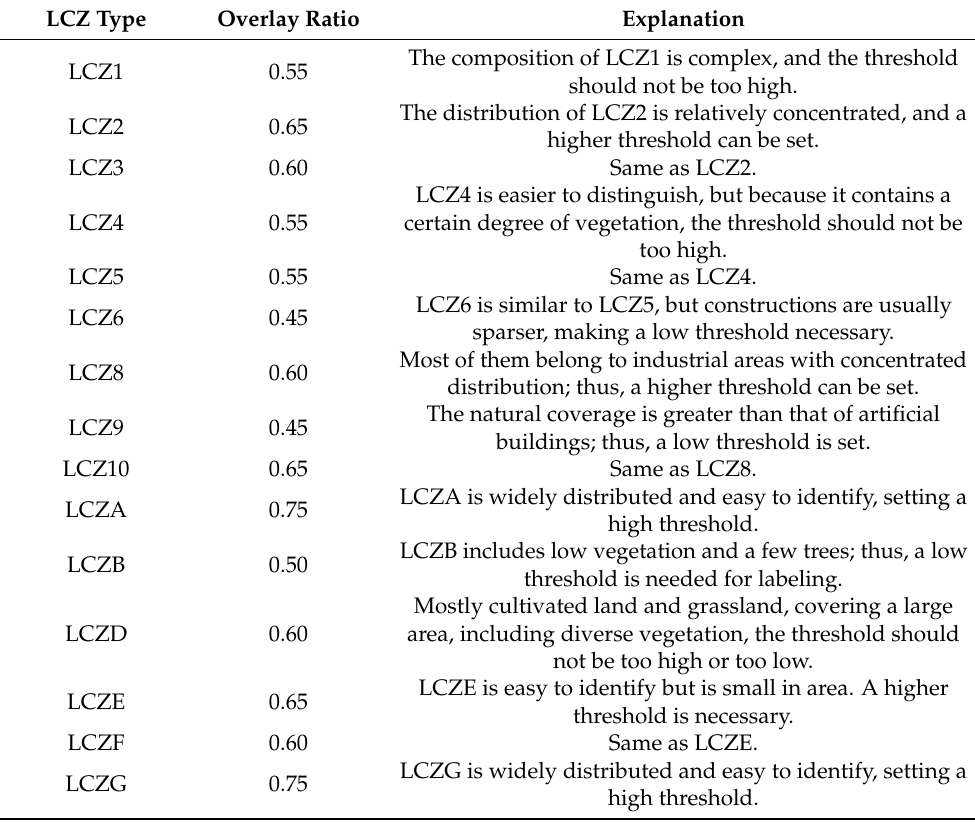
Table 5. Overlay ratio settings for